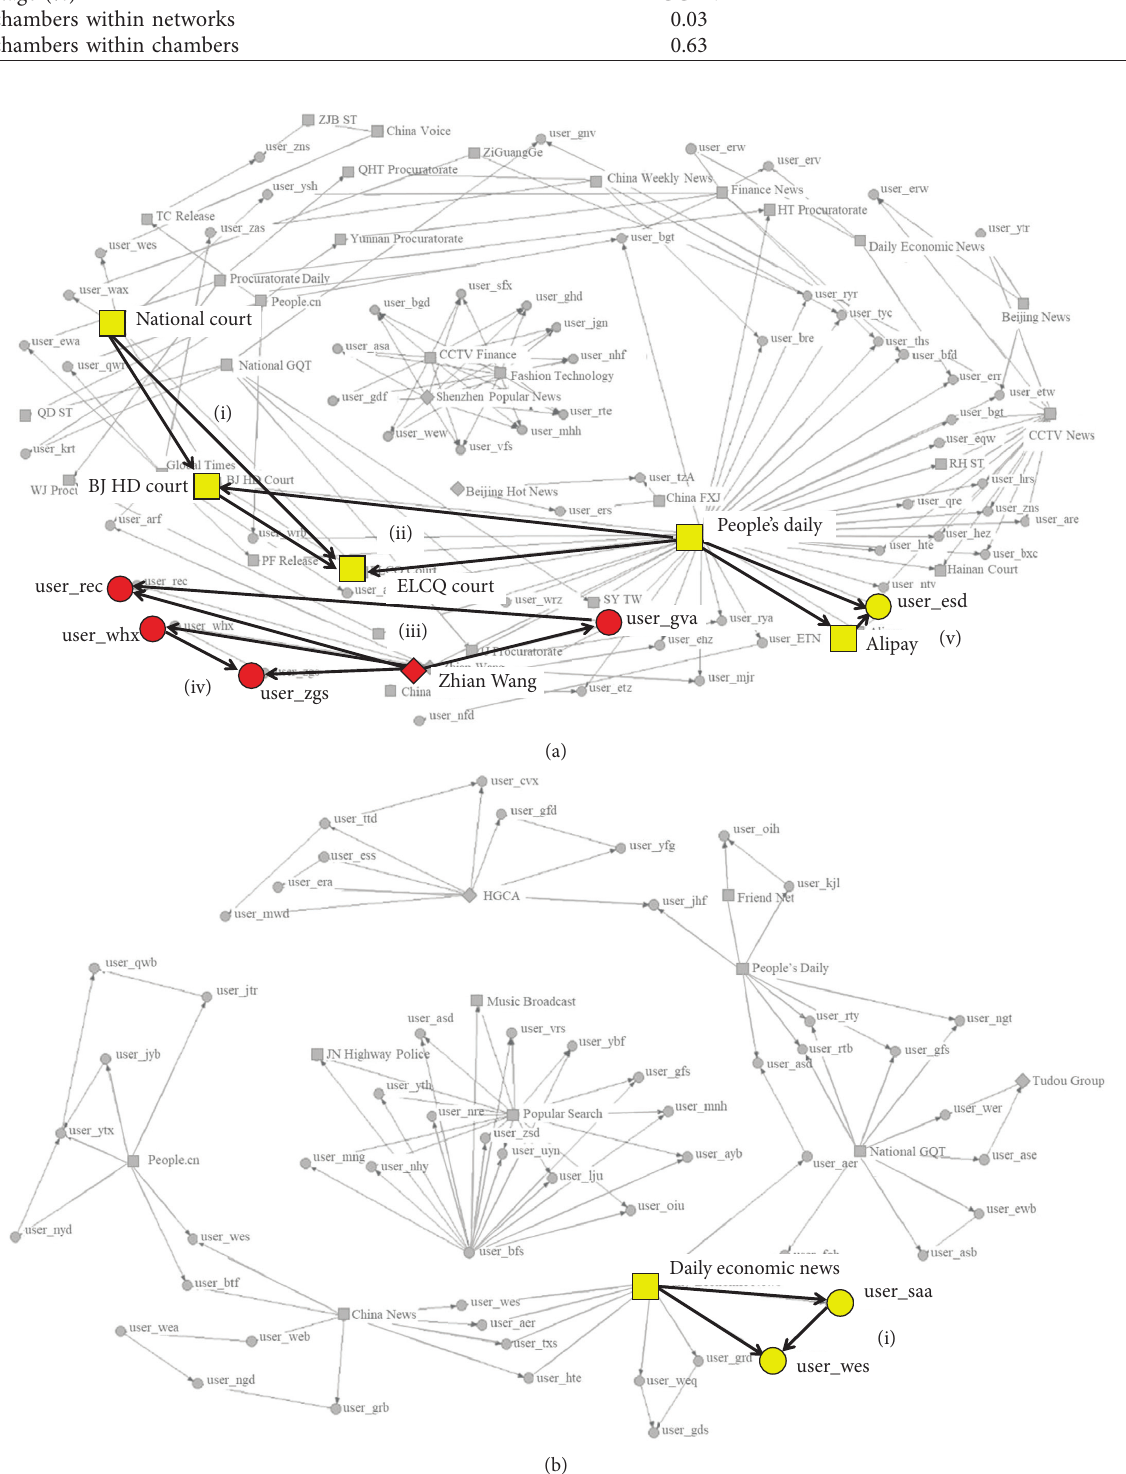
Figure 9: Illustration of the existence of echo chambers in the structure of (a) GCPN and (b) ECPN.